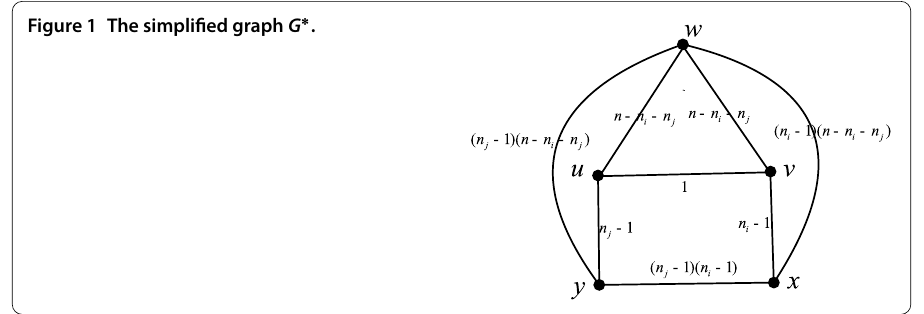
Figure 1 The simplified graph G ∗